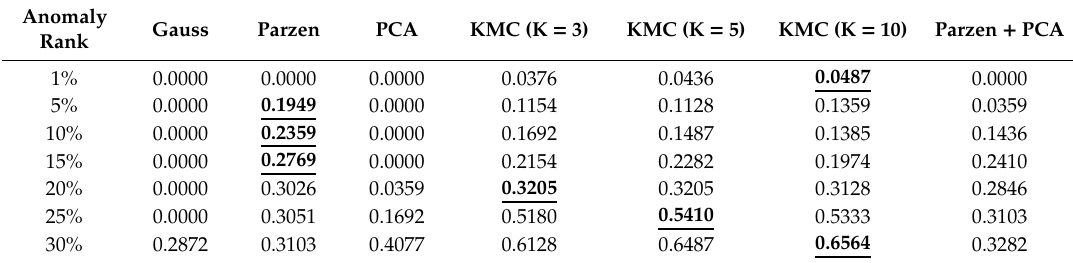
Table 15. True detection rate of each anomaly detection algorithm based on the e-mail contents dataset (Salesman). Best performance is shown in bold and underlined (number of normal behaviors in the test set: 64,425, number of malicious behaviors in the test set: